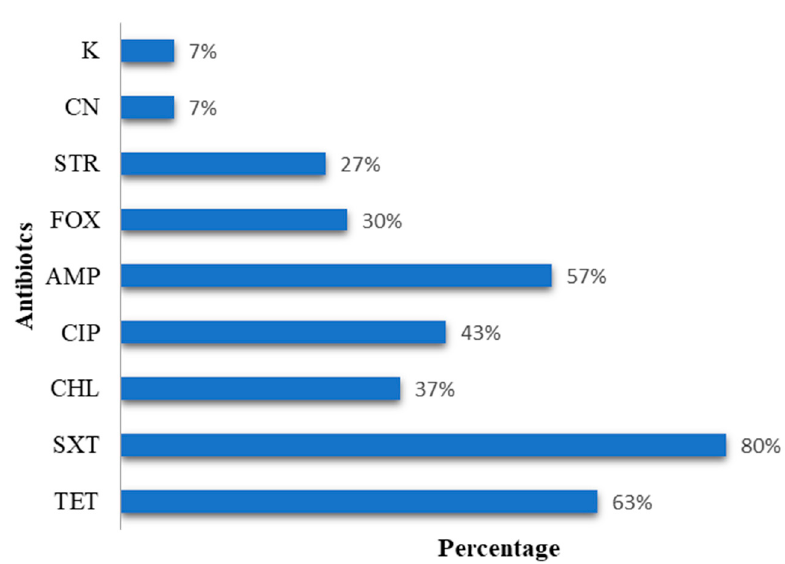
Figure 1. Percentage of phenotypic resistance for E. coli to the different antibiotics tested. It can be seen that more than half of the panel of strains are resistant to trimethoprim–sulfamethoxazole, tetracycline, and ampicillin antibiotics (80%, 63%, and 57%, respectively).